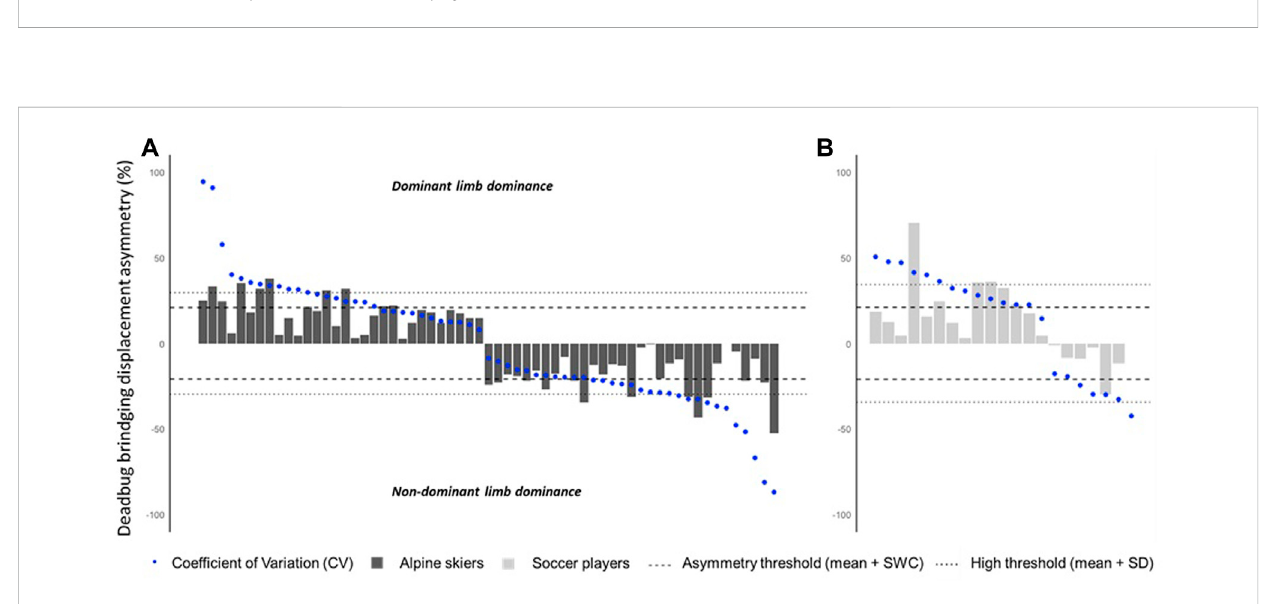
FIGURE 3 (A,B) Individual deadbug bridging displacement (DBB displacement ) asymmetry data (bars) with respective coef fi cients of variation (blue bullet points), thresholds for small to moderate asymmetry [population mean + smallest worthwhile change (SWC), dashed lines], and thresholds for high